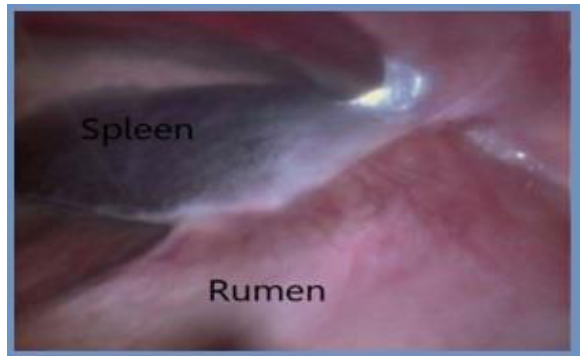
Figure, 8: The adhesion between site of partial splenectomy and at 30 days rumen in goat group